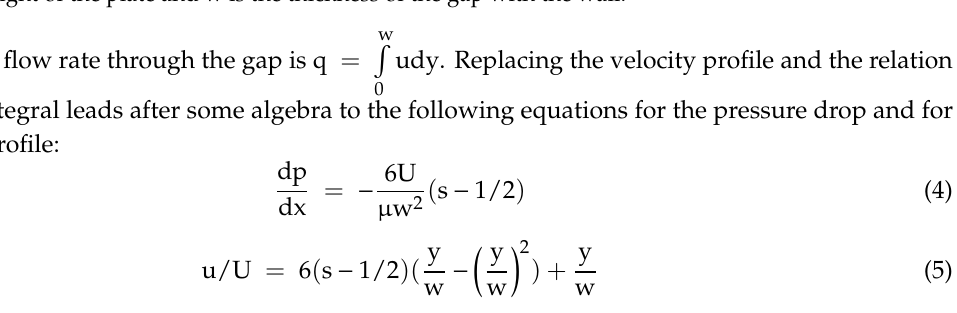
Figure 15. Geometry of piston plates: Definition of variables and coordinate systems for ( a ) 2-dimensional case, (x-y dimensions visible) and ( b ) 3-dimensional case (x-z dimensions visible); δ is the height of the plate and w is the thickness of the gap with the